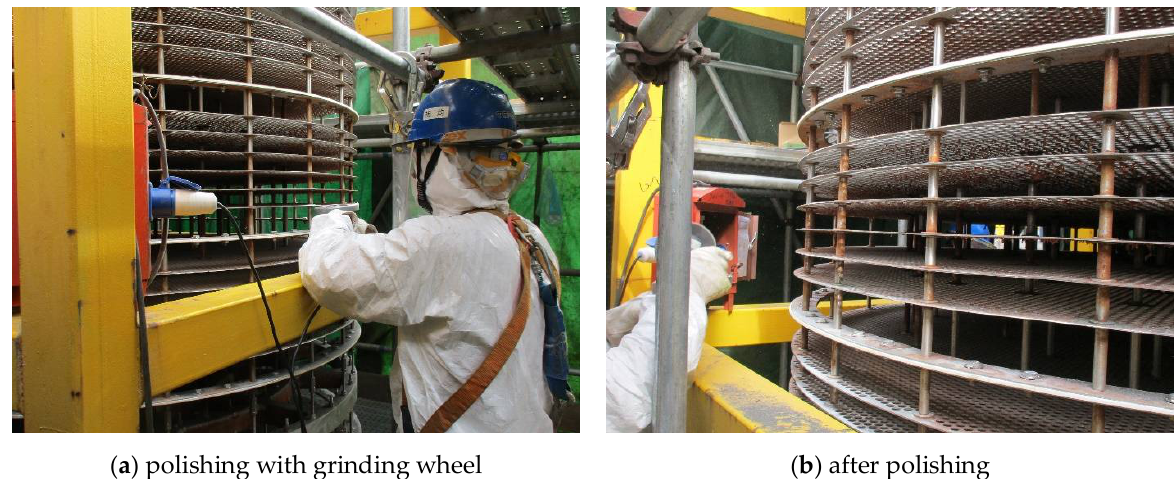
Figure 14. Field personnel polishing the periphery of the sieve plates and the PTFE baffles.